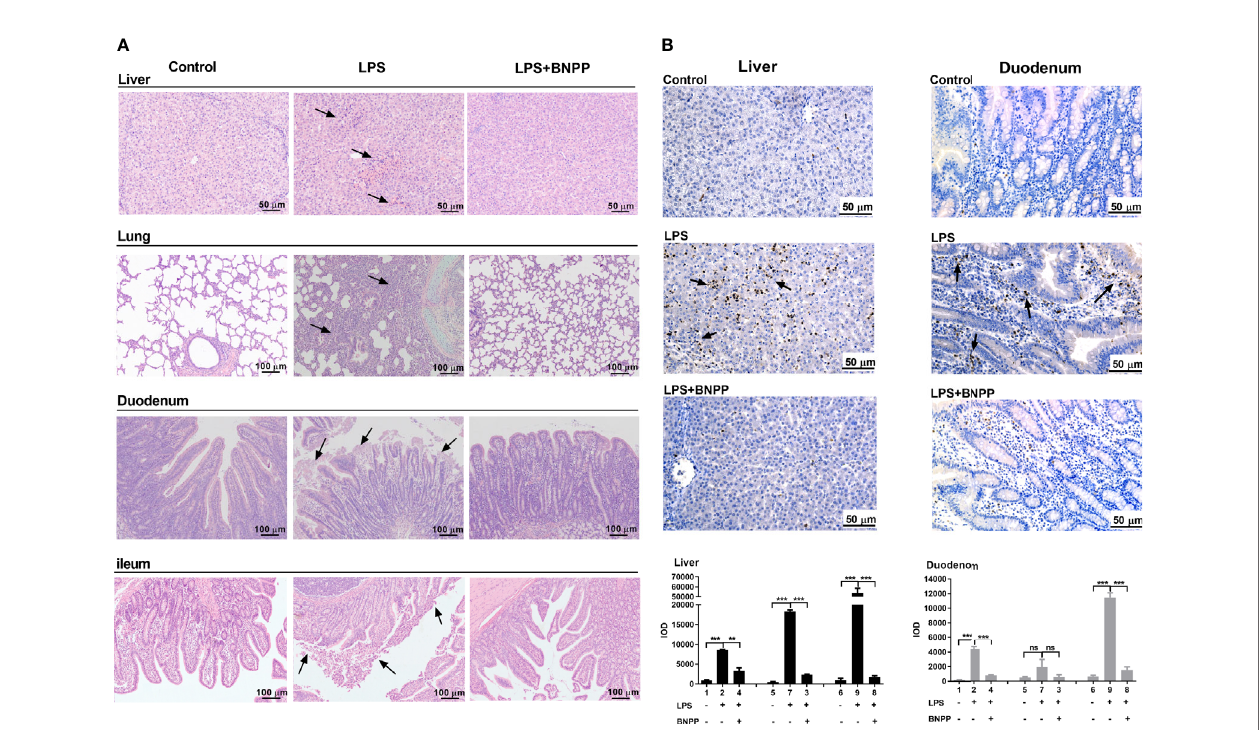
FIGURE 6 | PLE inactivation attenuates tissue injury and the in fl ammatory response in vivo . (A) Pathological examination (H&E staining) of pig tissues. Pigs (n=3) were treated with sterile saline or LPS (25 µg/kg) or the combination of LPS and BNPP (25 mg/kg, i.p., given prior to 1 h of LPS induction). Then, tissue injuries were detected after 24 h. (B) Neutrophil in fi ltration was assessed by MPO staining (brown staining), and quantitative analysis was performed by CaseViewer software. Representative images are shown, and the black arrow shows the damage in the tissues. Integral optical density (IOD) is the value of the light absorbed or transmitted by the result of dye staining in different tissue cells under the same illumination condition. The numbers in the fi gures represent the corresponding pigs. Statistical signi fi cance was indicated by asterisks (**P < 0.01; ***P <